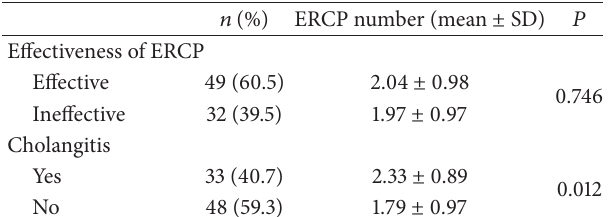
Table 2: Effectiveness of ERCP and cholangitis development by ERCP number.